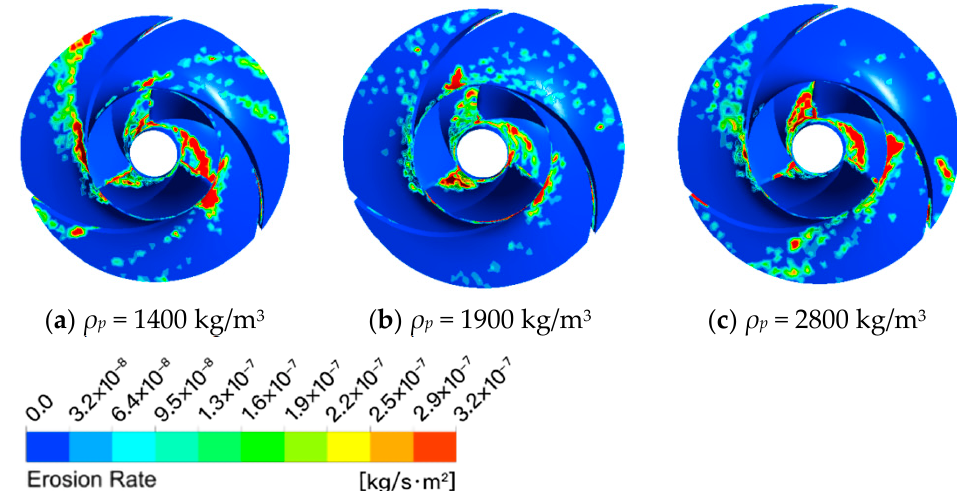
Figure 14. Wear distribution on the impeller surface.